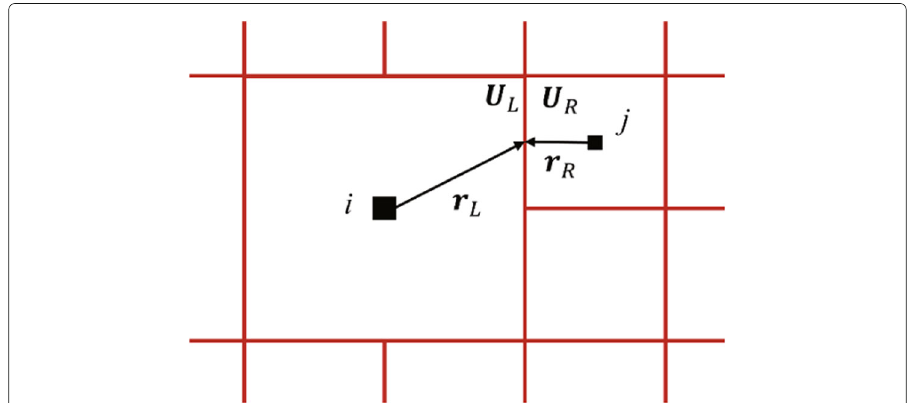
Fig. 1 Reconstructions of the states on adaptive Cartesian